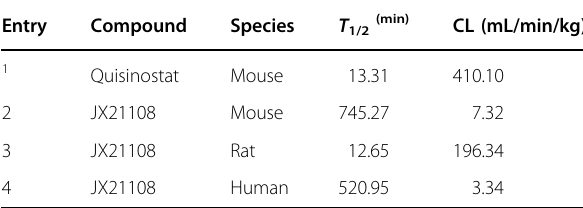
Table 1 In vitro drug metabolic stability of quisinostat and JX21108 in liver microsomes.